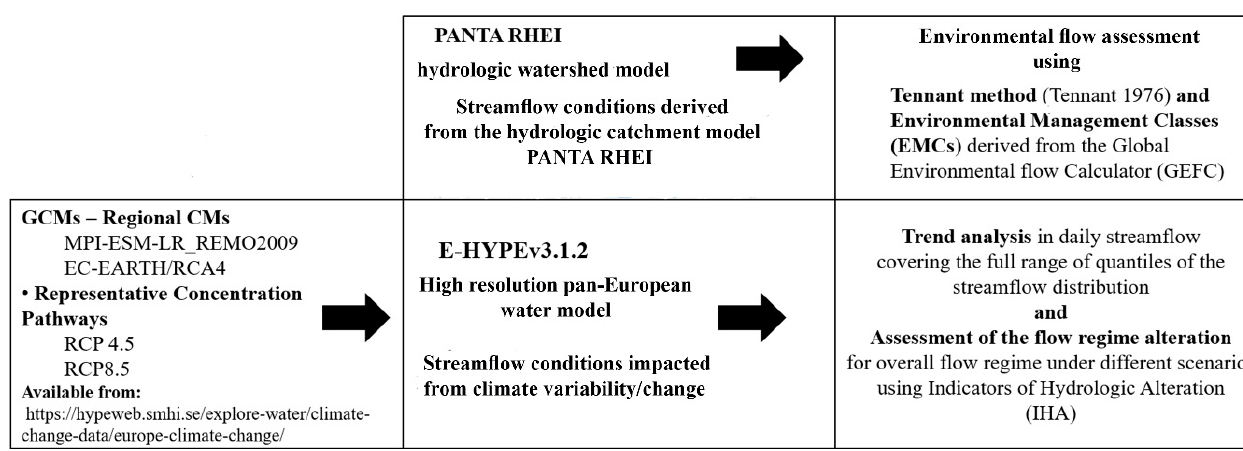
Figure 2. Overall procedures for environmental flow assessment in this study.